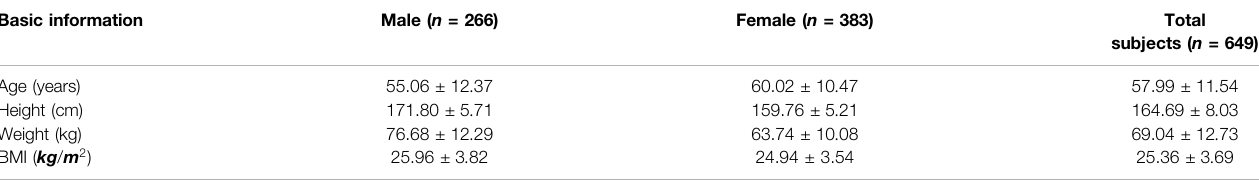
TABLE 1 | Basic information of included subjects.